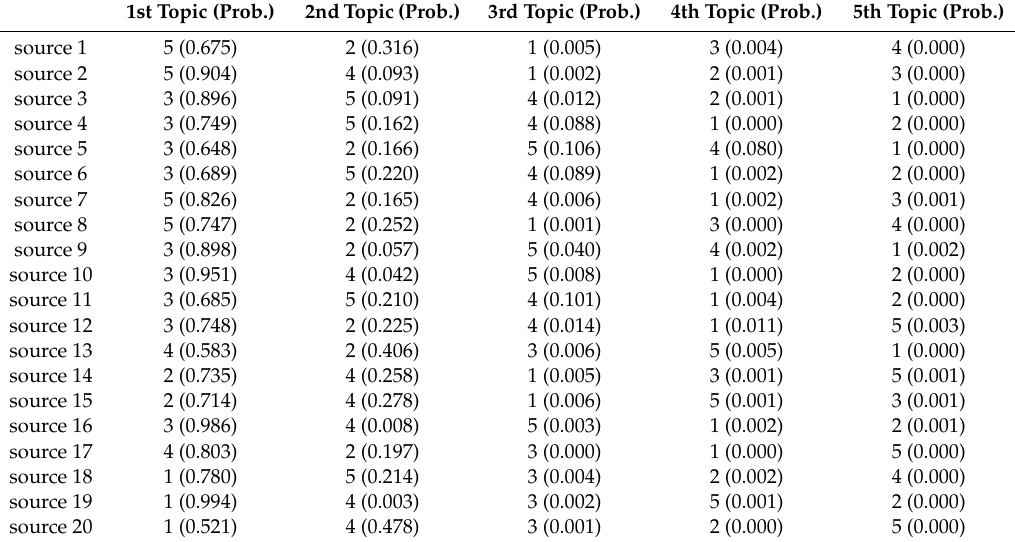
Table 6. Topic assignment probabilities from the ERT for the 20 laser welding images. 1st Topic